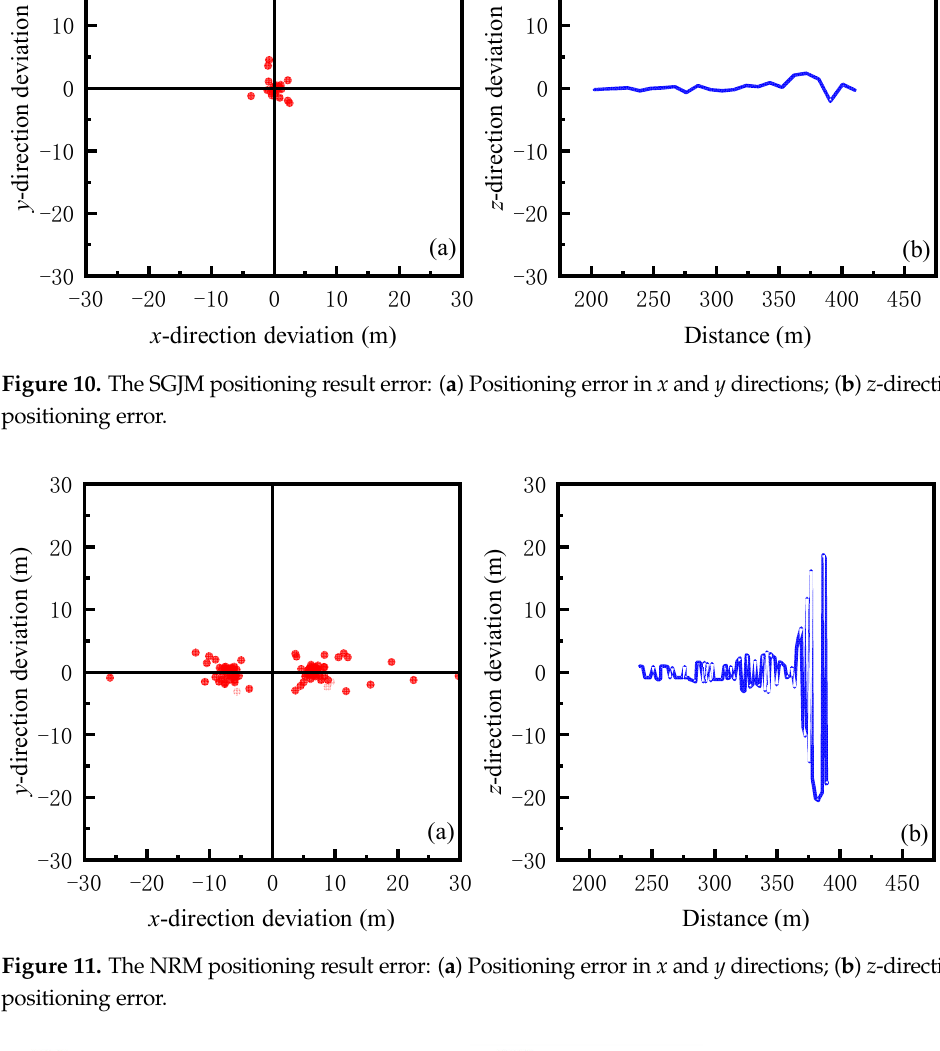
Figure 11. The NRM positioning result error: ( a ) Positioning error in x and y directions; ( b ) z -directional positioning error.